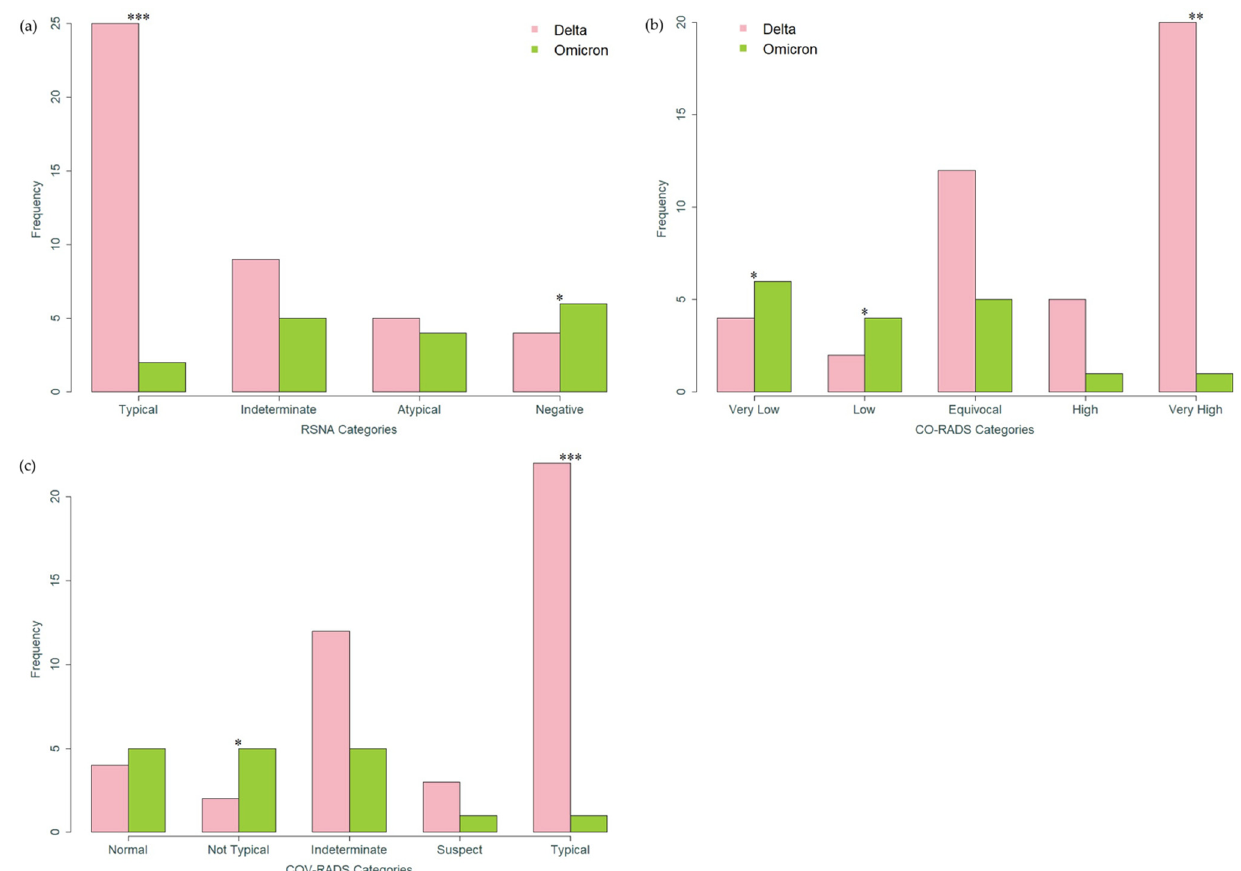
Figure 1. Bar charts with p -values from Fisher’s exact test. ( a ) Distribution of COVID-19 radiological RSNA scoring system according to virus variant. ( b ) Distribution of COVID-19 radiological CO-RADS scoring system according to virus variant. ( c ) Distribution of COVID-19 radiological COV-RADS scoring system according to virus variant. * ( p < 0.05), ** ( p < 0.01), *** ( p ≤ 0.001) (see Table 2). In multivariate analysis, after adjustment for vaccination status and stage of infec- tion, these correlations remained significant in the categories “typical appearance” (RSNA), “very high” degree of suspicion (CO-RADS), and “typical” (COV-RADS) with outcome “categories” with an 8-, 9- and 11-fold higher odds for the Delta variant, respectively (Model 2: